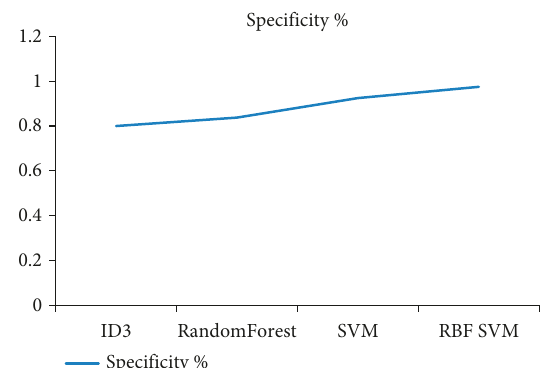
Figure 3: Specificity results of machine learning algorithms.